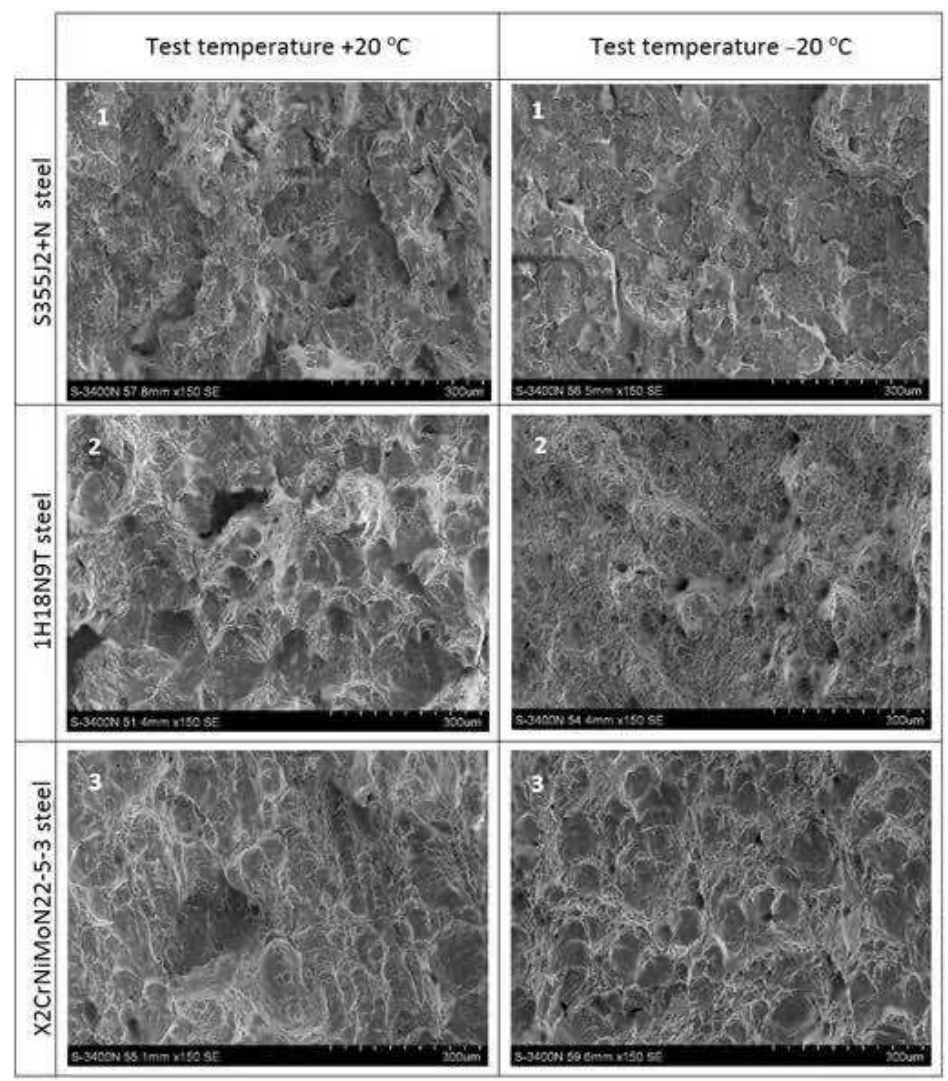
Figure 17. Typical fracture surfaces obtained on samples in the initial state (prior to the action of simulated